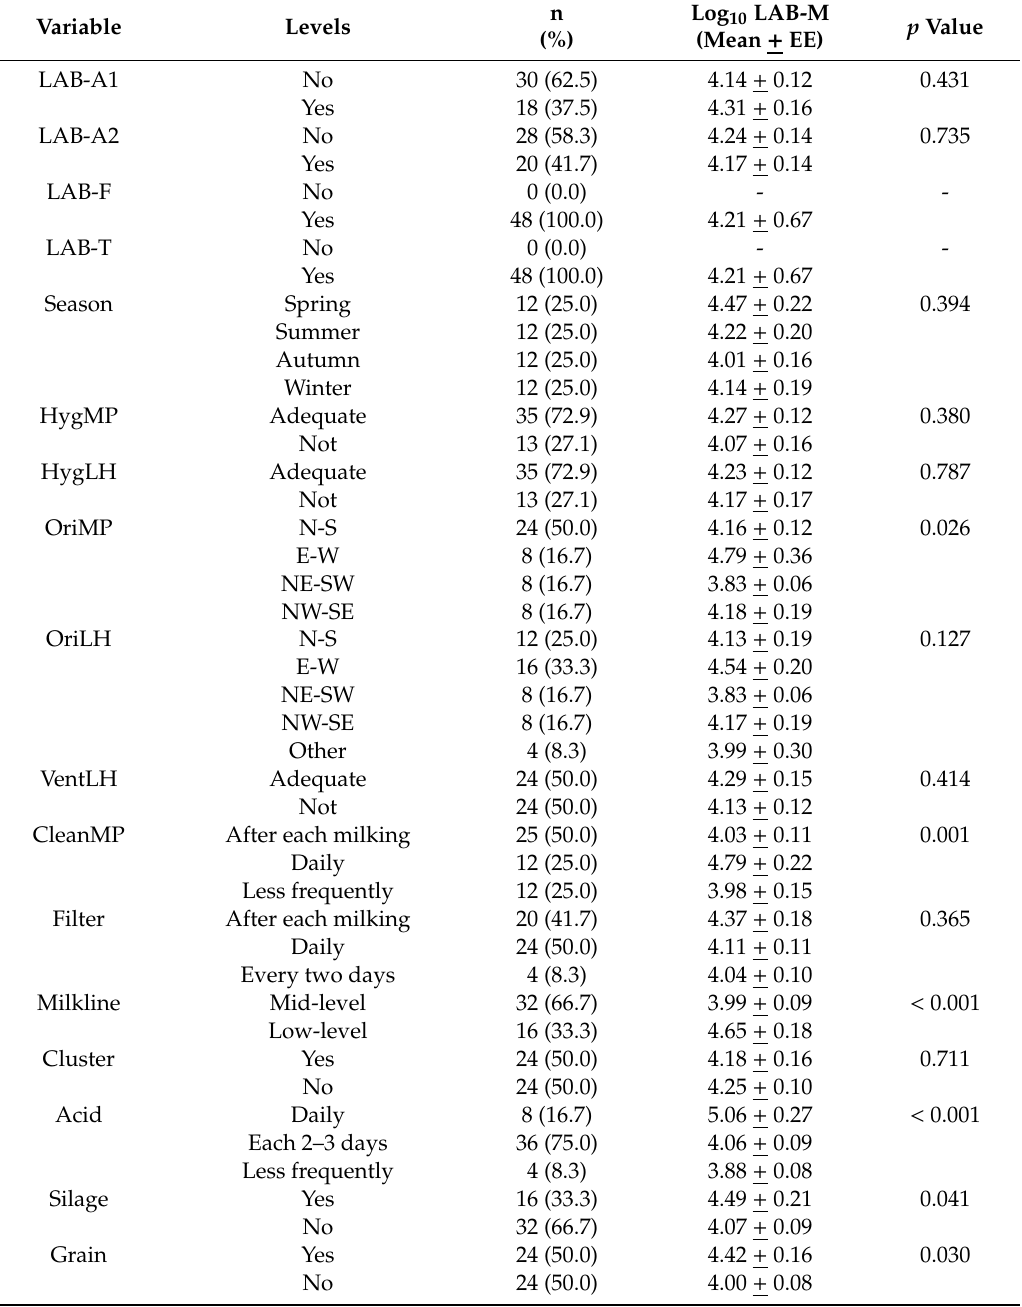
Table 3. Distribution of frequencies obtained by the farmers in the applied questionnaire and bivariate association (ANOVA or t -Student test) between the concentration of lactic microbiota in the milk (log 10 CFU / mL) and the considered categorical factors. Legend: LAB-A1 = presence of LAB in the air from the milking parlour, LAB-A2 = presence of LAB in the air from the livestock housing, Season = season of the year, HygMP = hygiene of the milking parlour, HygLH = hygiene of the livestock housing, OriMP = orientation of the milking parlour, OriLH = orientation of the livestock housing, VentLH = ventilation of the livestock housing, CleanMP = frequency of cleaning of the milking parlour, Filter = frequency of changing of milk filters, Milkline = milk pipeline height, Cluster = possibility of contact between the teat cups and the ground, Acid = frequency of use of acid for cleaning the milking machine, Silage = use of silage and Grain = use of grain during